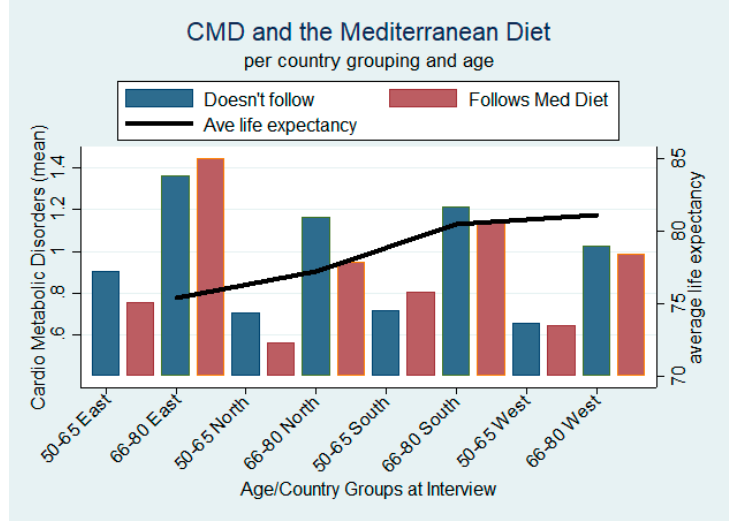
Figure 3. CMDs and the Mediterranean diet: by age and country groups.